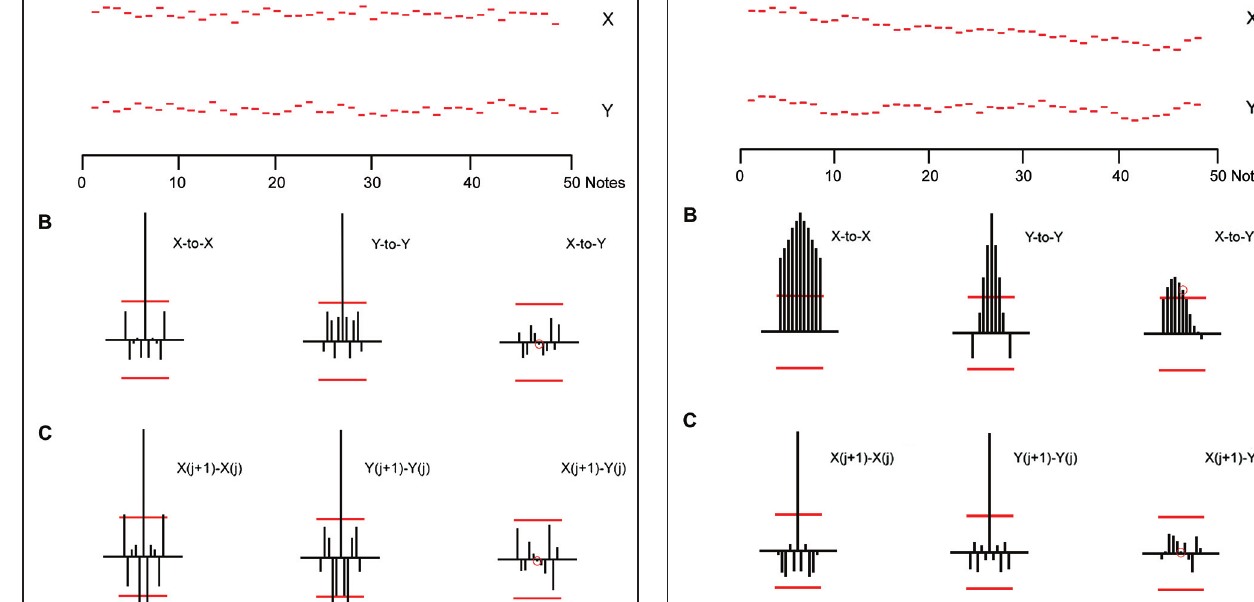
FIGURE 3 | (A) Alternating positions of X and Y simulated using a renewal model. (B) Serial correlation coefficients for the renewal model sequences shown above. Left: serial auto-correlation coefficients for X. Middle: same for Y. Right: cross-serial coefficients with X the reference. (C) Serial correlation coefficients for the sequential differences between simulated sequences. Left: Serial auto-correlation coefficients for the sequential differences within the renewal sequences X. Middle: Y sequence. Right: cross-serial correlations between sequential X and Y differences. X is the reference.